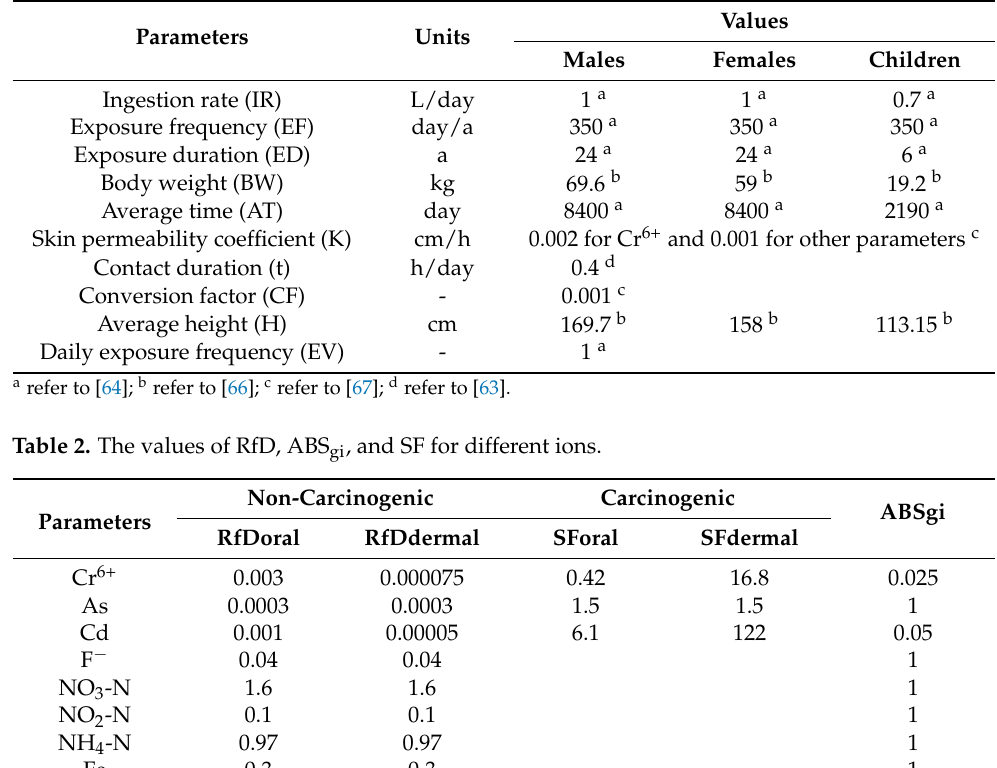
Table 1. Definition and values of key parameters for human health risk assessment.